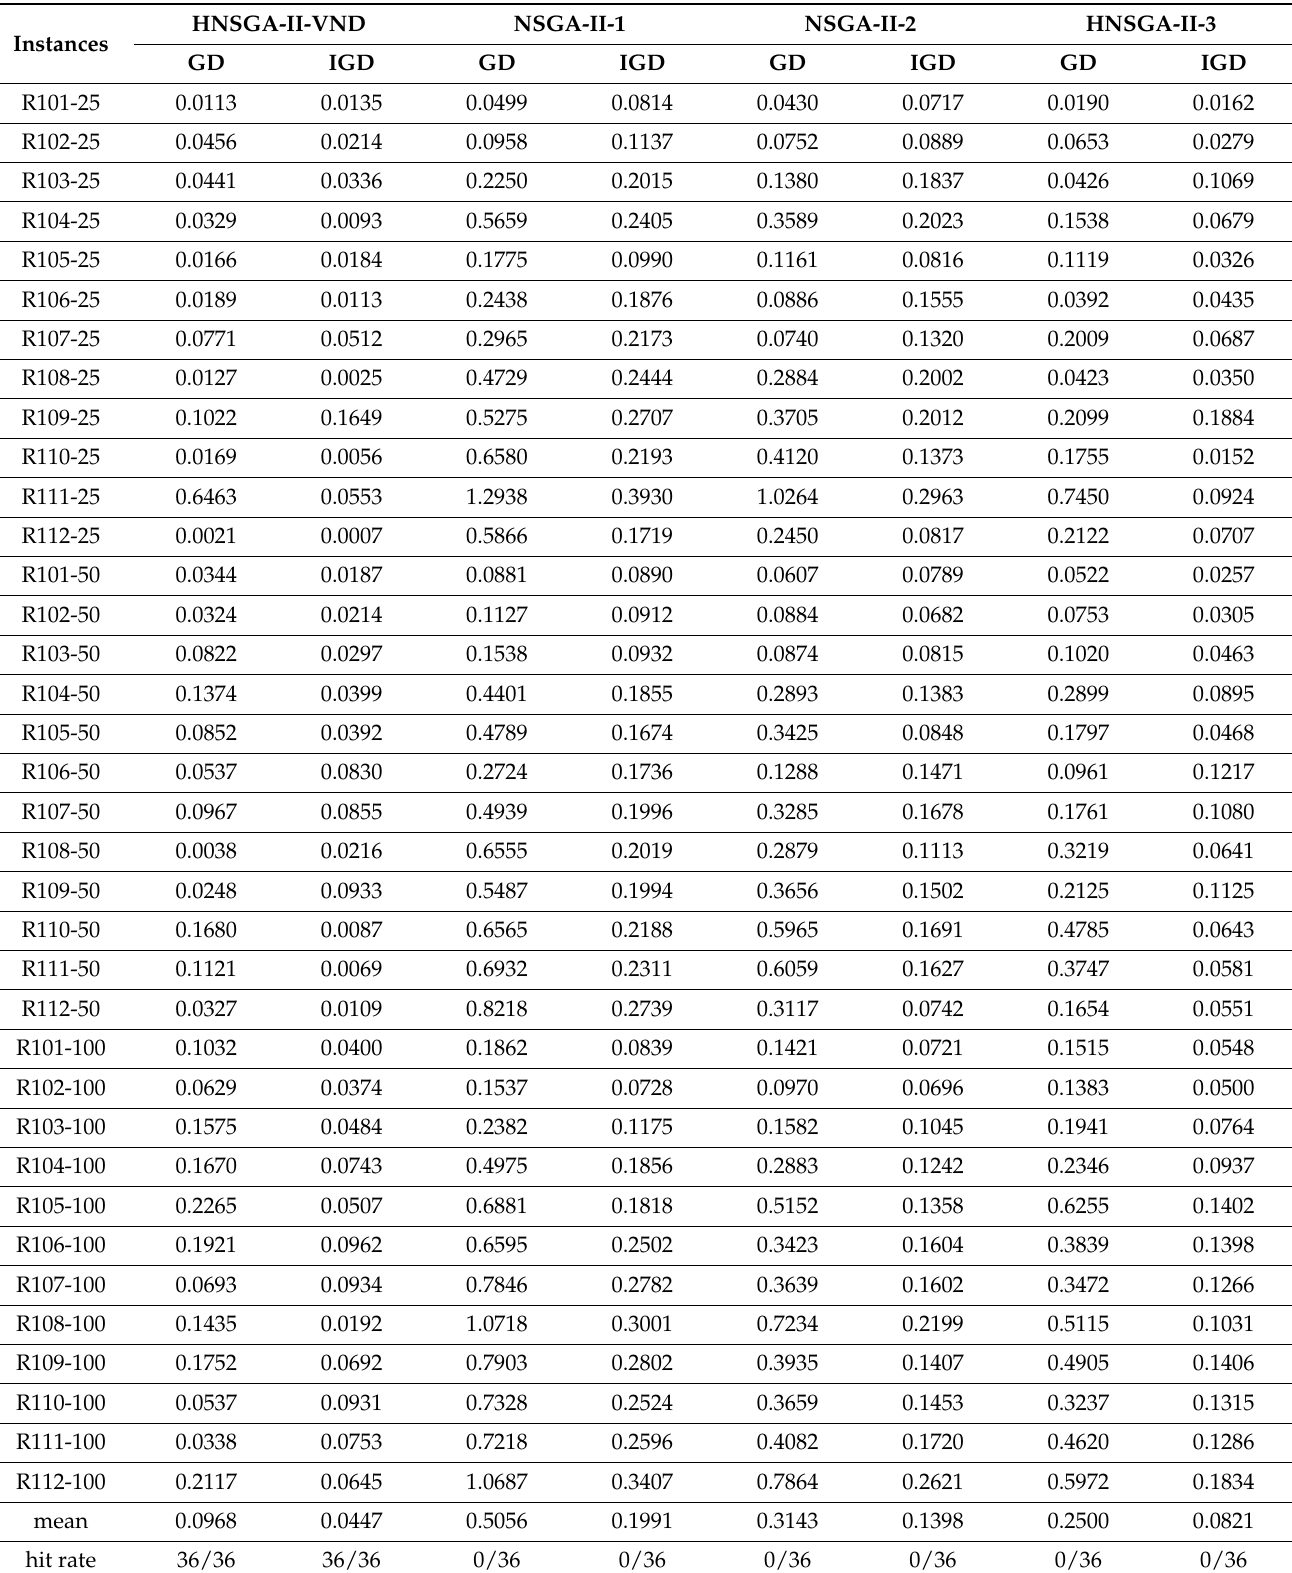
Table 3. The mean value of the metrics between HNSGA-II-VND and its variants in